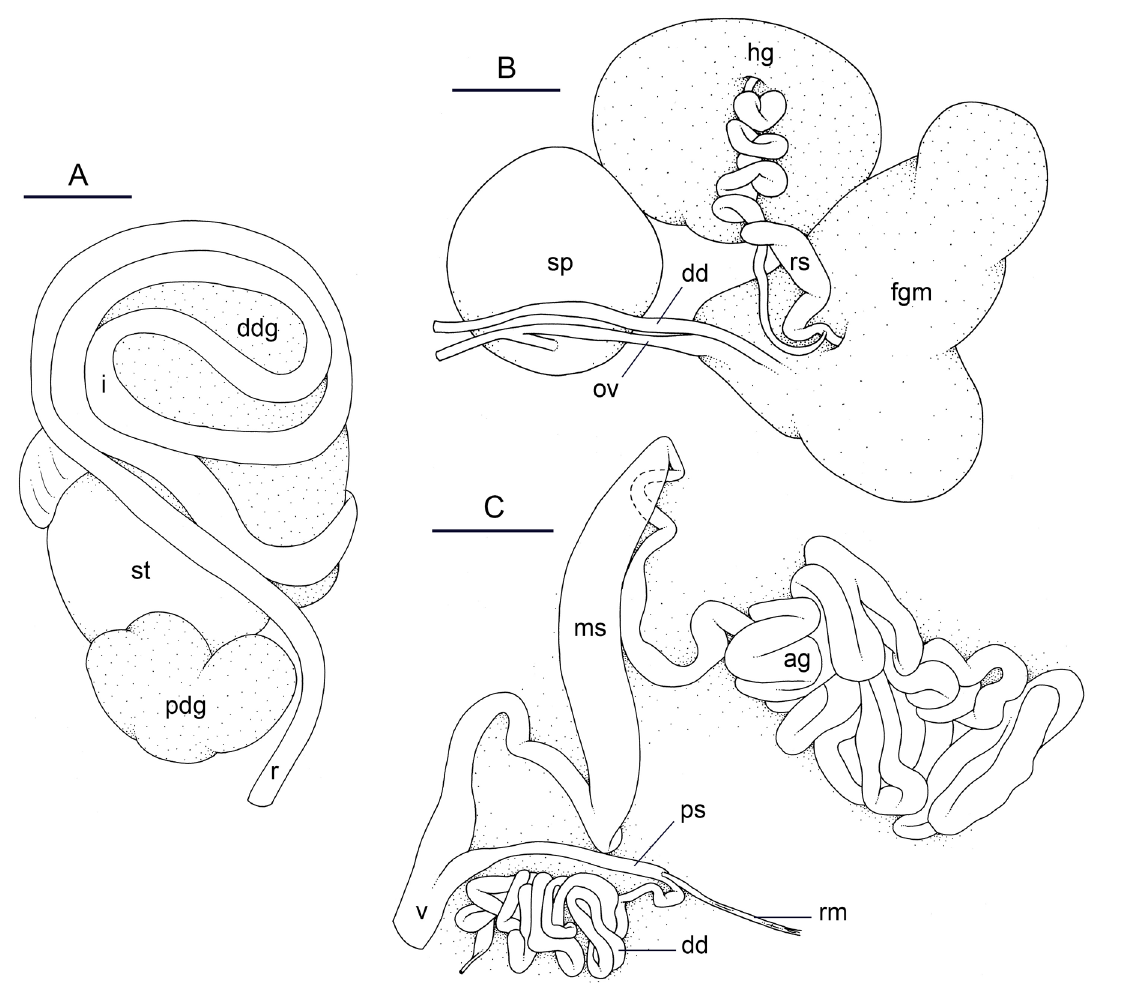
Fig. 34. Paromoionchis boholensis gen. et sp. nov., unit #2, Indonesia, Bali [3117] (UMIZ 00140). A . Digestive system. B . Posterior hermaphroditic (female) reproductive system. C . Male copulatory organs. Abbreviations: ag = accessory penial gland; dd = deferent duct; ddg = dorsal lobe of digestive gland; fgm = female gland mass; hd = hermaphroditic duct; hg = hermaphroditic gland; i =